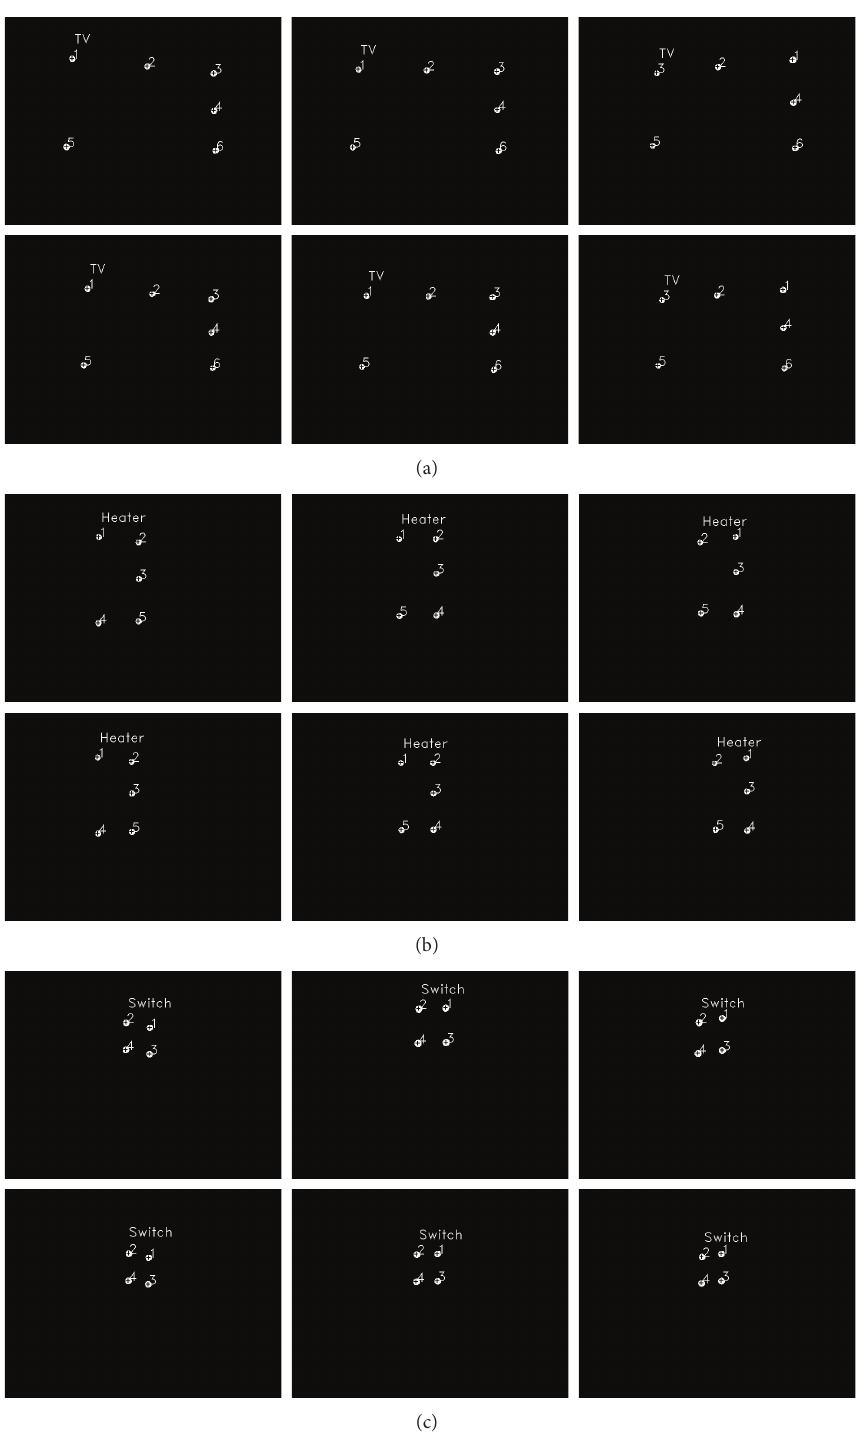
Figure 16: Images of (a) 60-inch television, (b) heater, and (c) air conditioner switch produced by the scene camera with different viewpoints and 𝑍 -distances (note that the 1st and 2nd row images of (a)–(c) indicate the near and far 𝑍 -distances, resp., and the 1st, 2nd, and 3rd column images of (a)–(c) indicate the left, center, and right viewpoints,